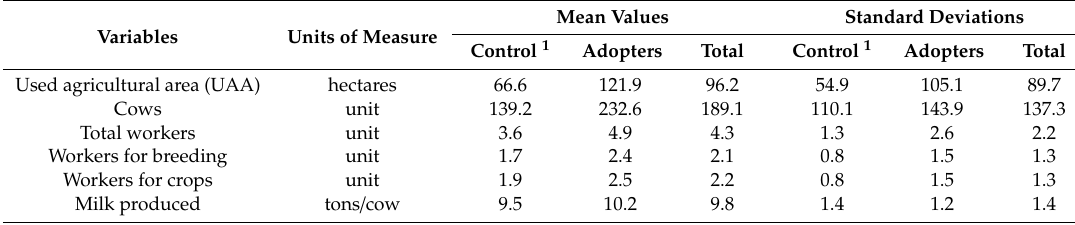
Table 1. Variables and descriptive statistics.